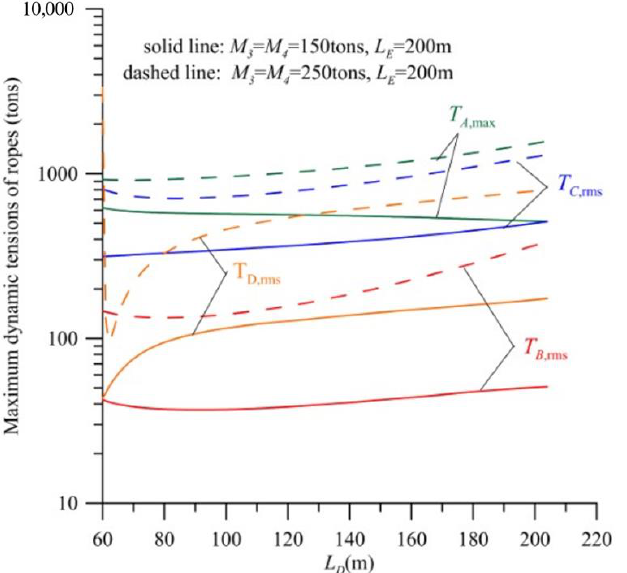
Figure 9. Dynamic tension of the four ropes under the typhoon irregular wave as a function of the diving length L D and the mass of pontoons M 3 and M 4 for L E = 200 m. diving length L D and the mass of pontoons M 3 and M 4 for L E = 200